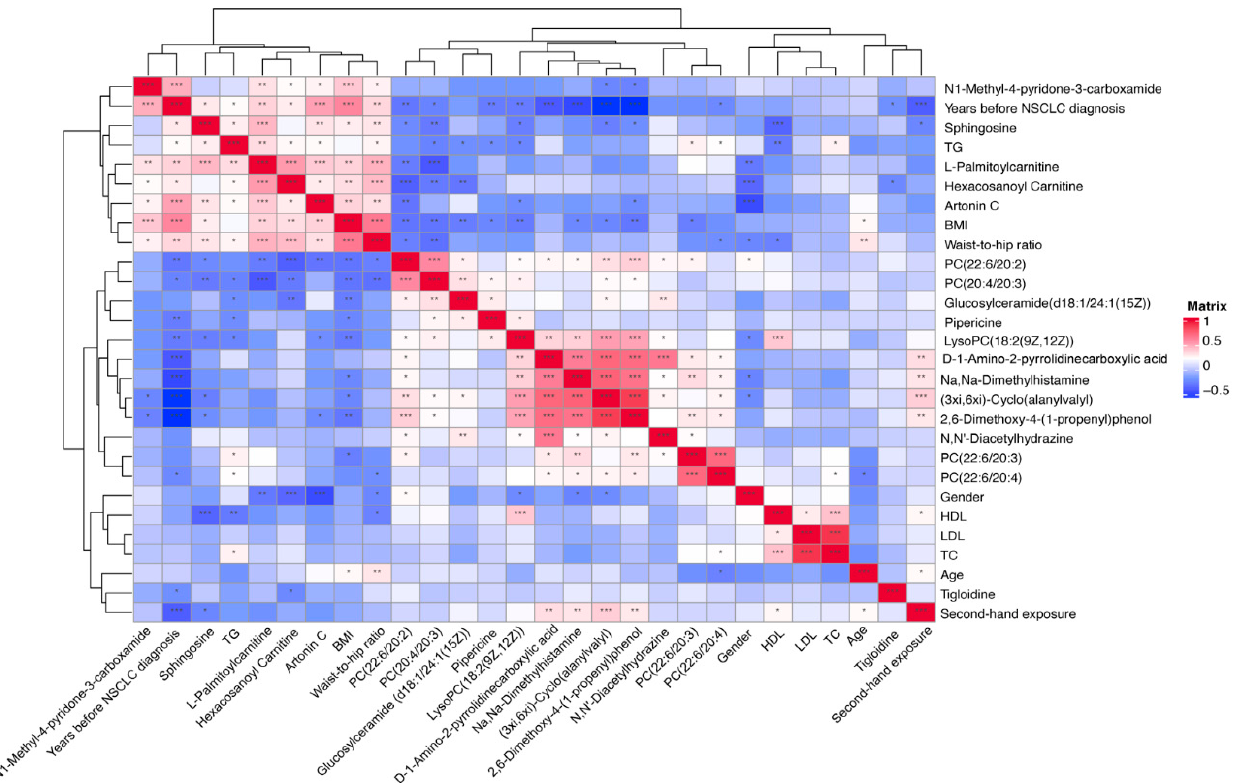
Figure 8. Spearman correlation matrix between significantly changed metabolites, classical lipids, and baseline characteristics in all subjects. Shades of blue represent a negative correlation coefficient; shades of red represent a positive correlation coefficient. Variables were ordered using a hierarchical clustering analysis. Threshold for significance testing of the Spearman correlation: 0.01 < p < 0.05, *; 0.001 < p < 0.01, **; p < 0.001, ***.